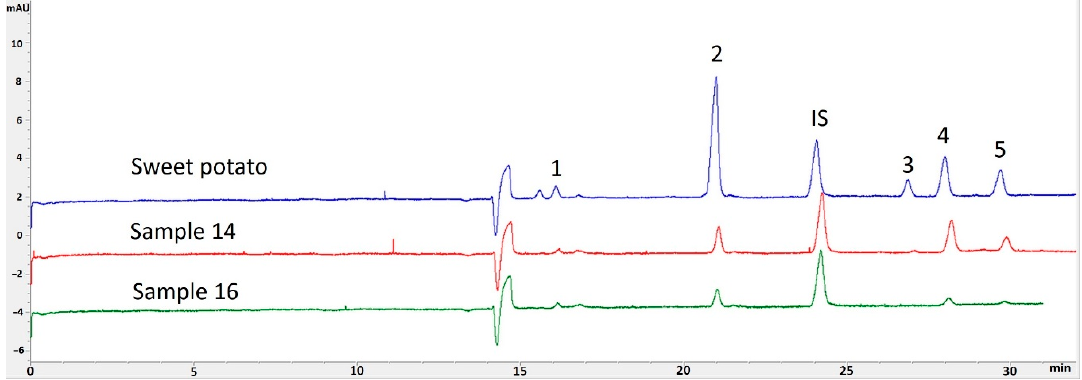
Figure 2. Electropherograms of sugar analysis from sweet potato tuber Sample 21 (blue), purple-fleshed cross-breed with Granola Sample 14 (red) and a meristem clone of Blue Congo sample 16 (green). Identification 1—myo-inositol, 2—sucrose, IS—internal standard, 3—maltose, 4—glucose, 5—fructose.